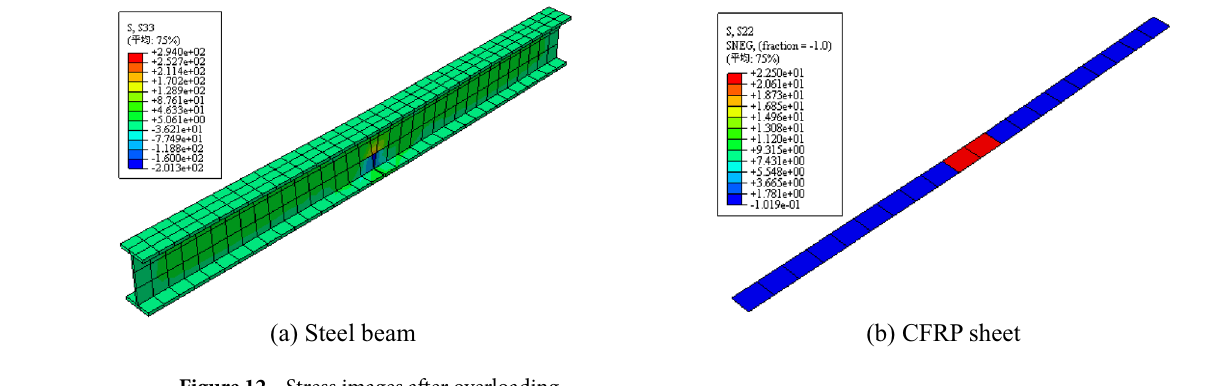
Figure 12. Stress images after overloading.